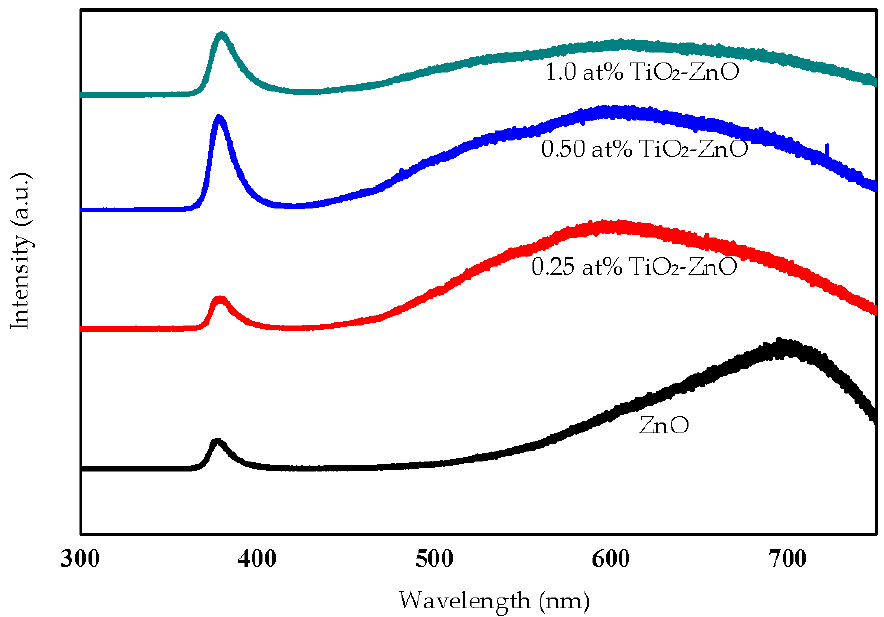
Figure 9. PL spectra of ZnO, 0.25 at % TiO 2 -ZnO, 0.50 at % TiO 2 -ZnO, and 1.0 at % TiO 2 -ZnO (excitation: λ = 514 nm).